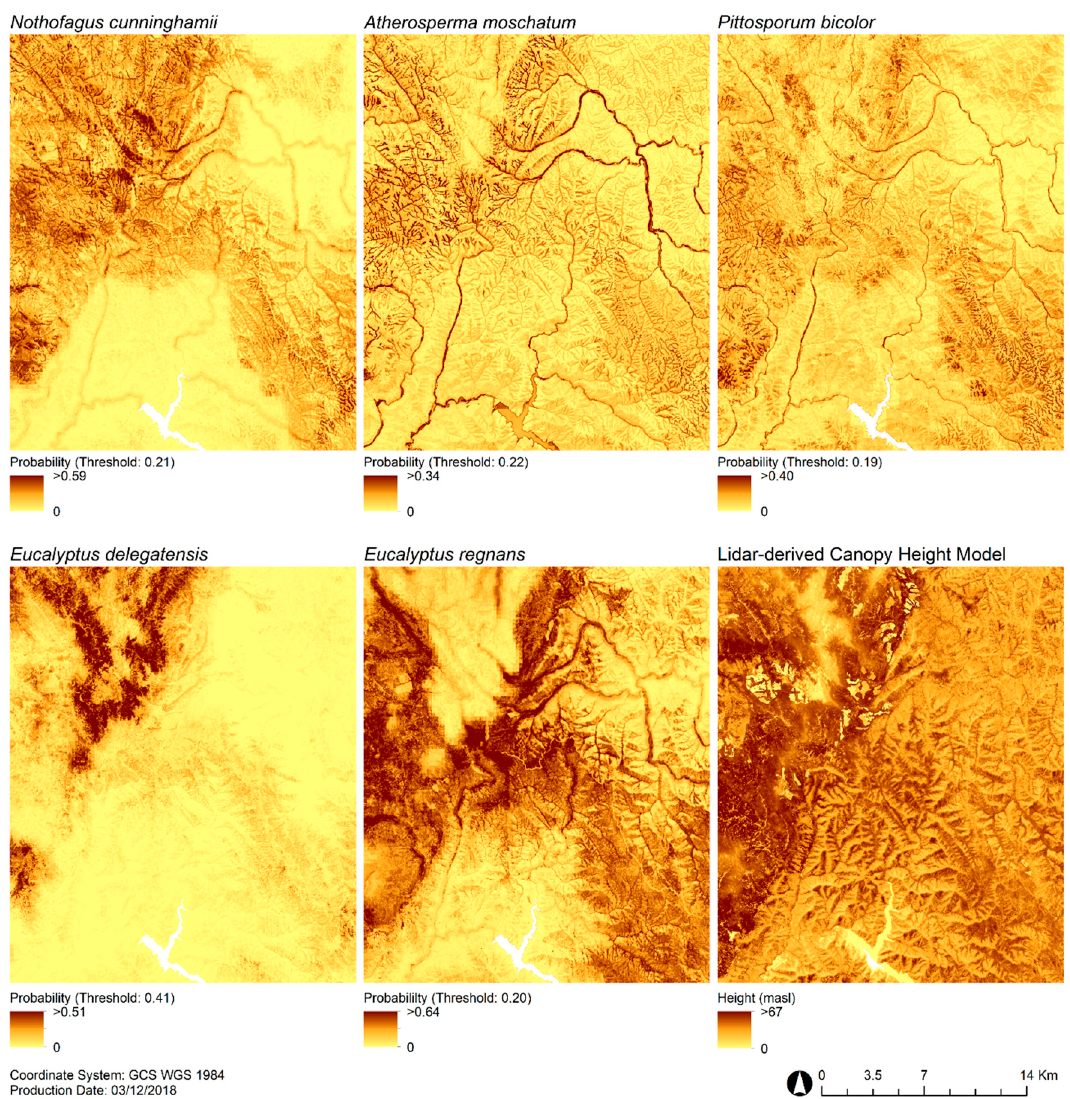
Figure 5. Predicted spatial distribution of five species and canopy heights (greater than 6 m) used to construct the landscape species model and the predictive ecosystem mapping (PEM) model across a subset of the study region encompassing extent 1 (see Figure 1). Thresholds indicate the value at which the true positive rate and true negative rate are maximized for cross-validated data when classifying maps into binary predictions of presence or absence for each species.